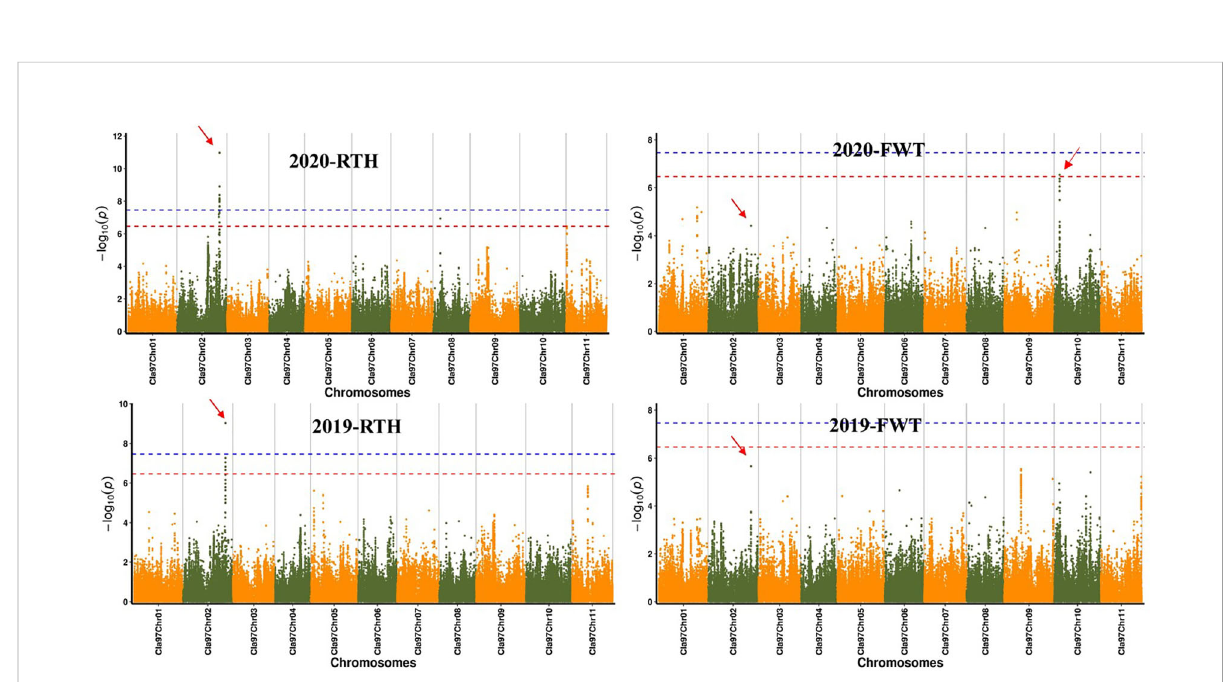
FIGURE 2 Manhattan plot of watermelon rind thickness and single fruit weight by GWAS in 2019 and 2020. The abscissa represents the chromosome, the ordinate represents -log 10 ( p -value), and the red and blue line segments parallel to the coordinate axis represent the two threshold lines, SNPs over red represent highly signi fi cant positive associations with traits, SNPs over blue are signi fi cantly associated with traits,